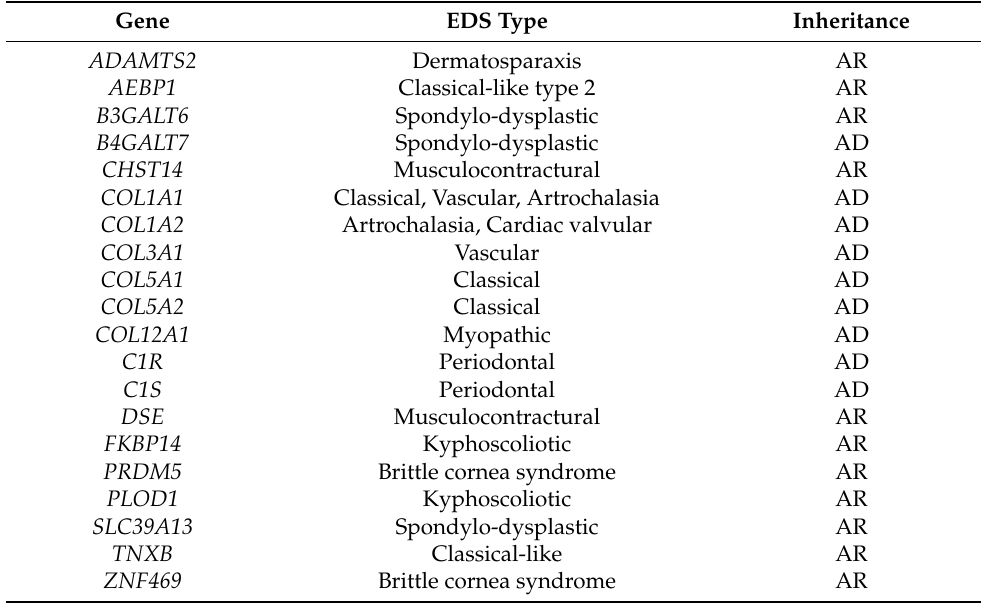
Table 1. Overview on genetic causes of human Ehlers-Danlos syndrome (EDS), adapted from [2]. Gene EDS Type Inheritance ADAMTS2 Dermatosparaxis AR AEBP1 Classical-like type 2 AR B3GALT6 Spondylo-dysplastic AR B4GALT7 Spondylo-dysplastic AD CHST14 Musculocontractural AR COL1A1 AD